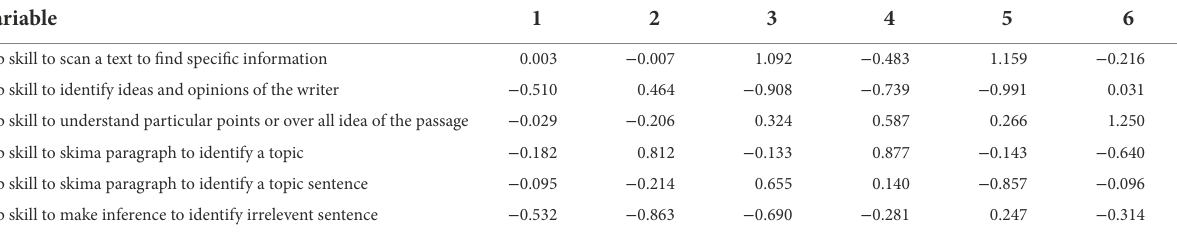
TABLE 11 Canonical coefficients for set